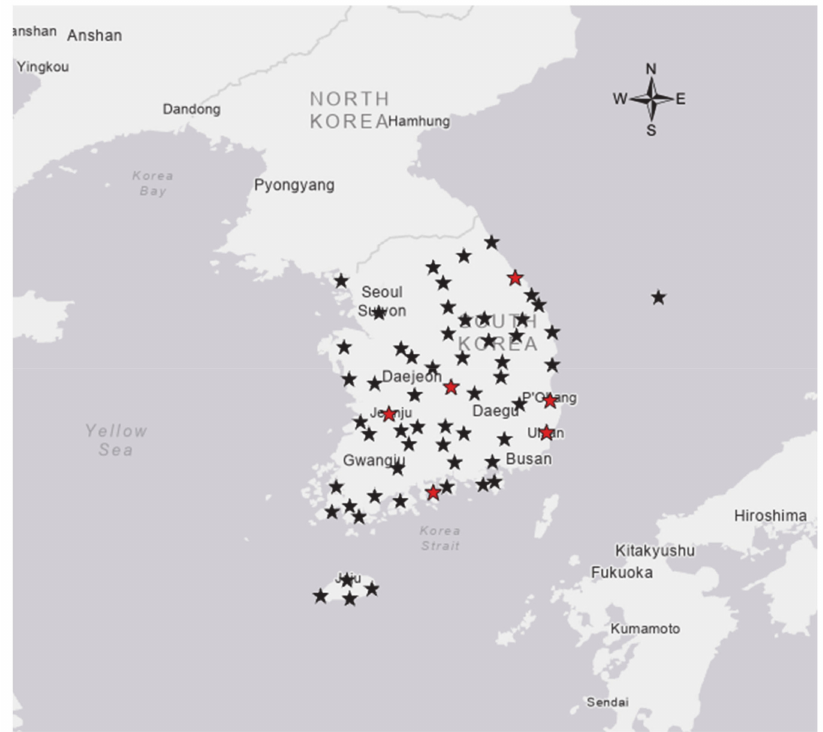
Figure 1. Locations of the 61 meteorological and phenological observation points in Korea that were used in this study. Among them, six sites marked by red stars used weather data and phenological data from 1936~1975 as well as